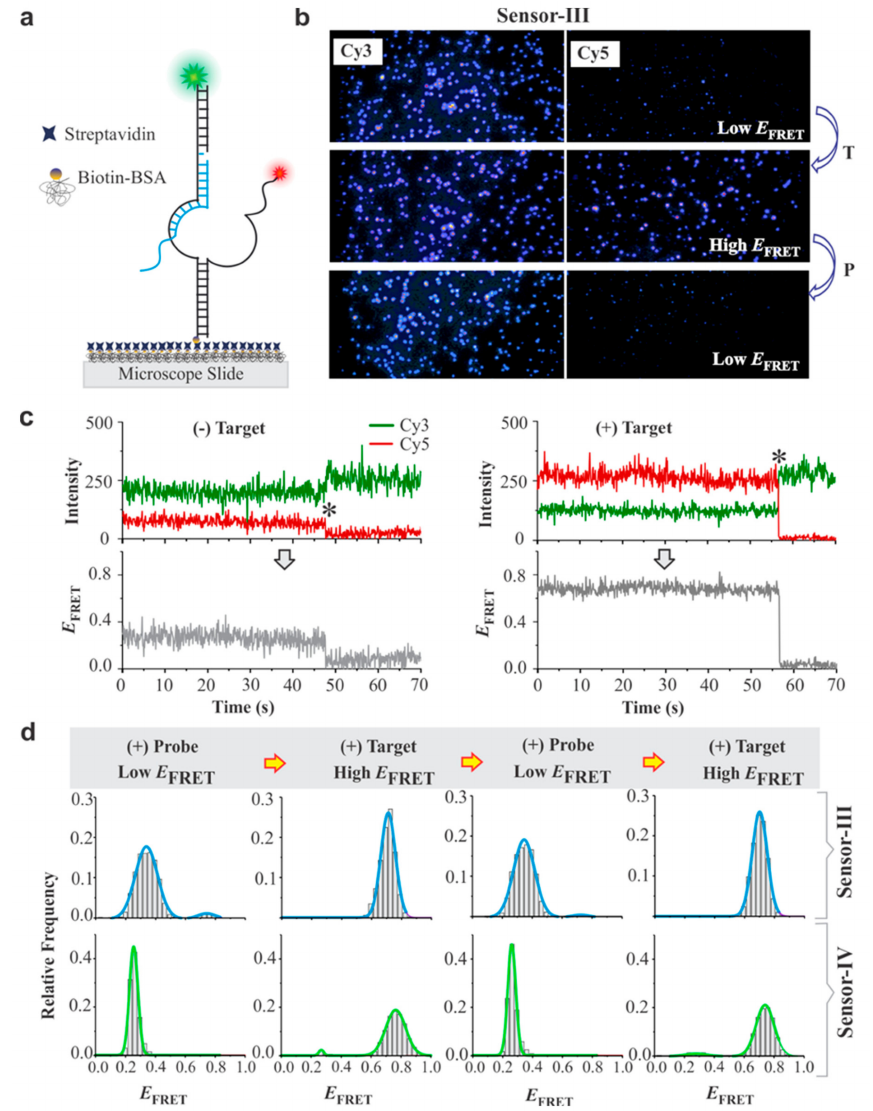
Figure 3. Single molecule analysis of DNA sensors. ( a ) Experimental setup for the prism-based total internal reflection fluorescence (pTIRF) microscopy analysis of sensors. The quartz slide was coated with biotin bovine serum albumin (bBSA) and then streptavidin. The sensor molecules were immobilized on the slide via biotin–streptavidin interaction. ( b ) Fluorescence images of surface-immobilized sensor-III before (top) and after addition of target DNA (middle). The image of the same microscope slide after addition of probe (bottom). ( c ) Typical single molecule traces of sensor-III. Left: open conformation (low- E FRET state); right: closed conformation (high- E FRET state). Top panels display fluorescence intensities of the donor (Cy3: green) and the accepter (Cy5: red) fluorophore and the bottom panel depicts FRET e ffi ciencies calculated from the corresponding intensity–time traces. The asterisks indicate the photobleaching events of Cy5 fluorophores. ( d ) single-molecule FRET (smFRET) histograms of sensors III and IV each switching between the low- and the high- E FRET conformations after alternate addition of an excess (1 µ M) probe (P) and target (T). Each E FRET histogram was prepared from 95–110